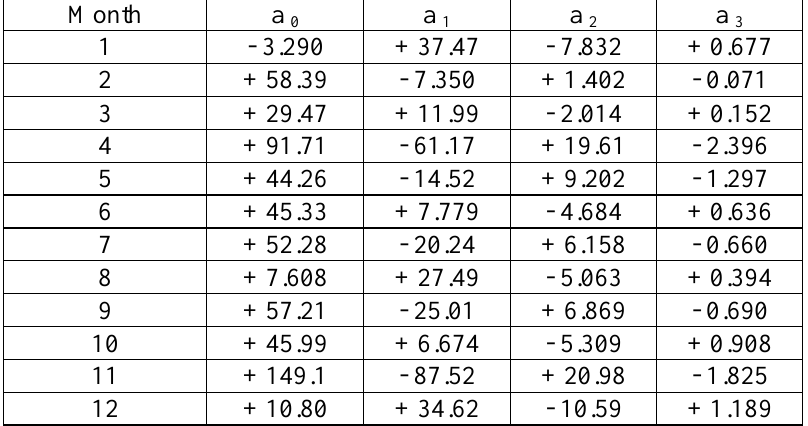
/U ) with days of year mp sw